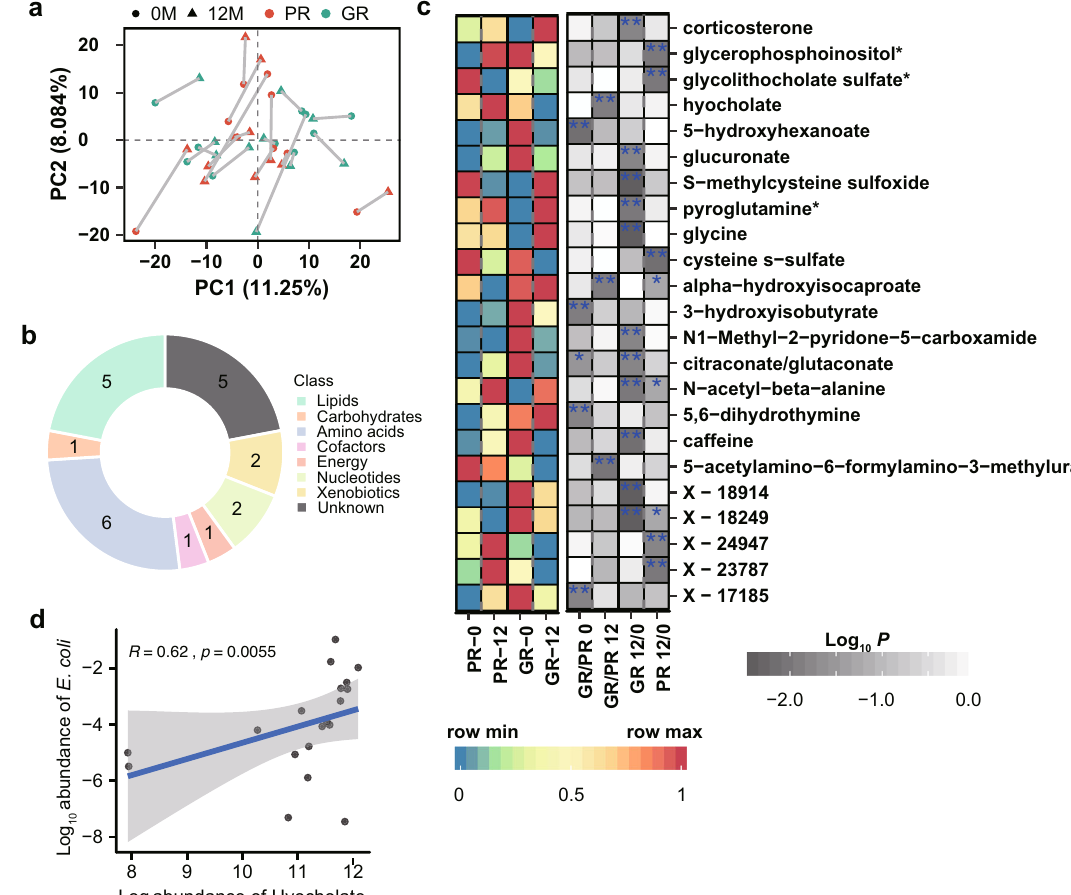
Fig. 4 Changes of metabolic pro fi les of the older women after treatment with L. reuteri . a The score plot of principal components analysis (PCA) based on metabolomic pro fi les in the GR ( n = 10) and PR ( n = 10) groups at baseline and 12 months. The blue and red colors indicate the GR and PR groups, respectively; The dot and triangle indicate the baseline (0 M) and 12 months (12 M), respectively. b Biological processes in which the differential metabolites are involved ( P < 0.01 by the Wilcoxon test). c The left heatmap shows scaled mean abundances of the differential metabolites in the PR ( n = 10) and GR ( n = 10) groups at two time points. The blue and red colors indicate the low and high abundances, respectively; The grey color in the right heatmap indicates P -value of comparative analysis; ‘ * ’ denotes P < 0.05; ‘ ** ’ denotes P < 0.01. d Association between metabolite hyocholate and the species E. coli . The blue line and grey shade indicate the regression line and 95% con fi dence interval; R denotes Spearman ’ s correlation coef fi